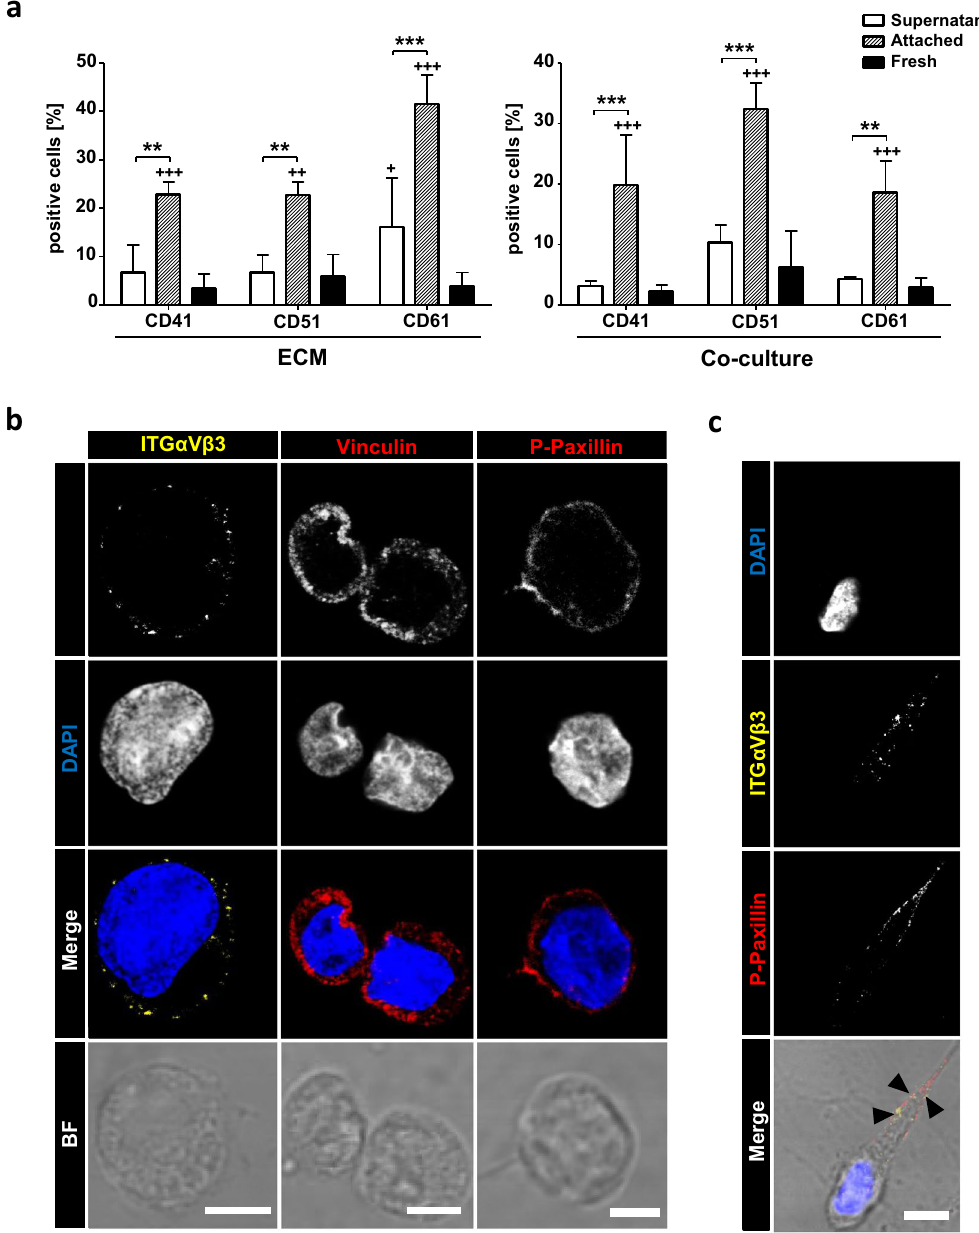
Figure 4. Integrins recognizing RGD-motives promotes active focal contact formation. ( a ) FACS analysis of freshly isolated cells or 5 days ECM or MSC co-cultured cells. Percent positive cells for ITG α IIb (CD41), ITG α V and ITG β 3 (CD61) are shown. n = 4, two-way ANOVA with Bonferroni post-hoc test; + = significance in comparison to fresh cells. Error bars, s.e.m.; * p < 0.05, ** p < 0.01, *** p < 0.001. ( b ) Confocal microscopy images of α -ITG α V β 3 (left panel, yellow), α -vinculin (mid penal, red), α -p-paxillin (right panel, red), nuclei DAPI (blue) staining, merge and corresponding brightfield images of 5 days cultured AT-cells. Bars = 5 µ m. ( c ) Confocal microscopy images of α -ITG α V β 3 (yellow), α -p-paxillin (right panel, red), nuclei DAPI (blue) staining and merge including corresponding brightfield image of 5 days cultured AT-cell. Arrowheads represent co-localization of ITG α V β 3 and p-paxillin in a cellular protrusion. Bar = 5 µ